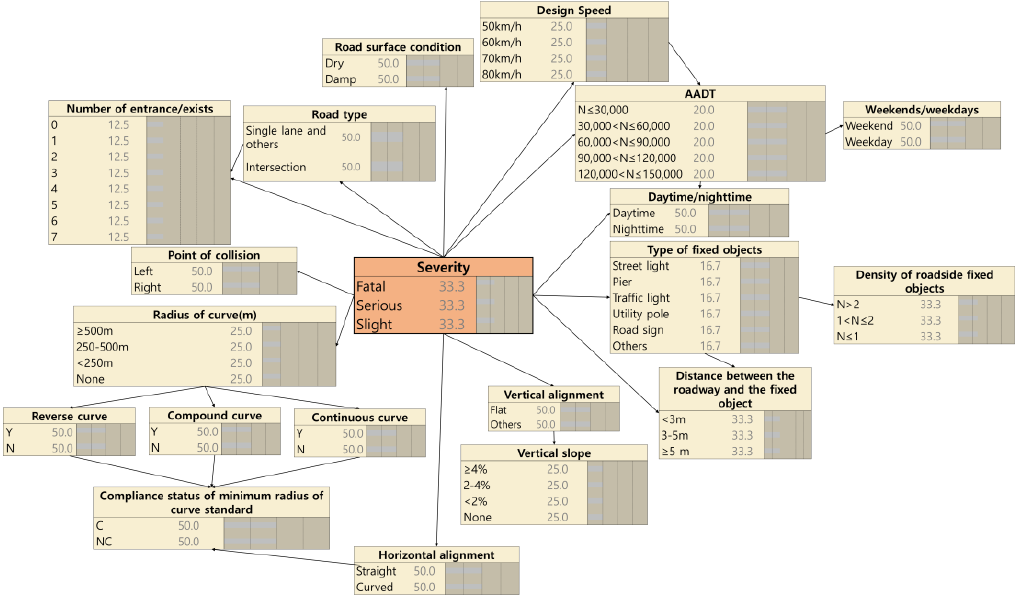
Figure 4. BN structure for RORC severity prediction.